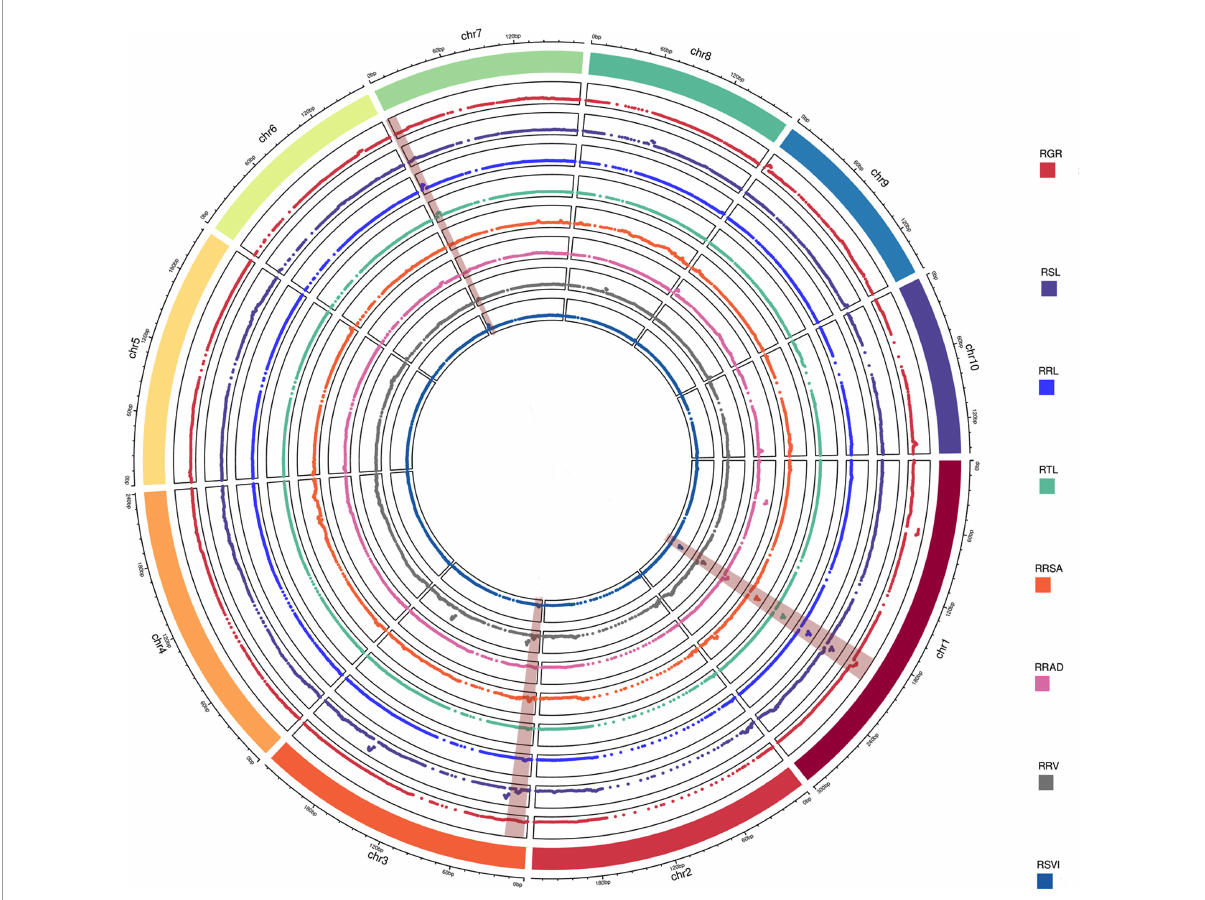
FIGURE2 QTL analysis in the RIL population related to low-temperature tolerance traits. The outermost box with scale represents the 10 maize chromosomes. For each trait, different colors represent the eight different traits related to low-temperature tolerance (RGR, RSL, RRL, RTL, RRSA, RRAD, RRV, and RSVI). The red backgrounds of chromosomes 1, 3, and 7 represent consistent QTLs.